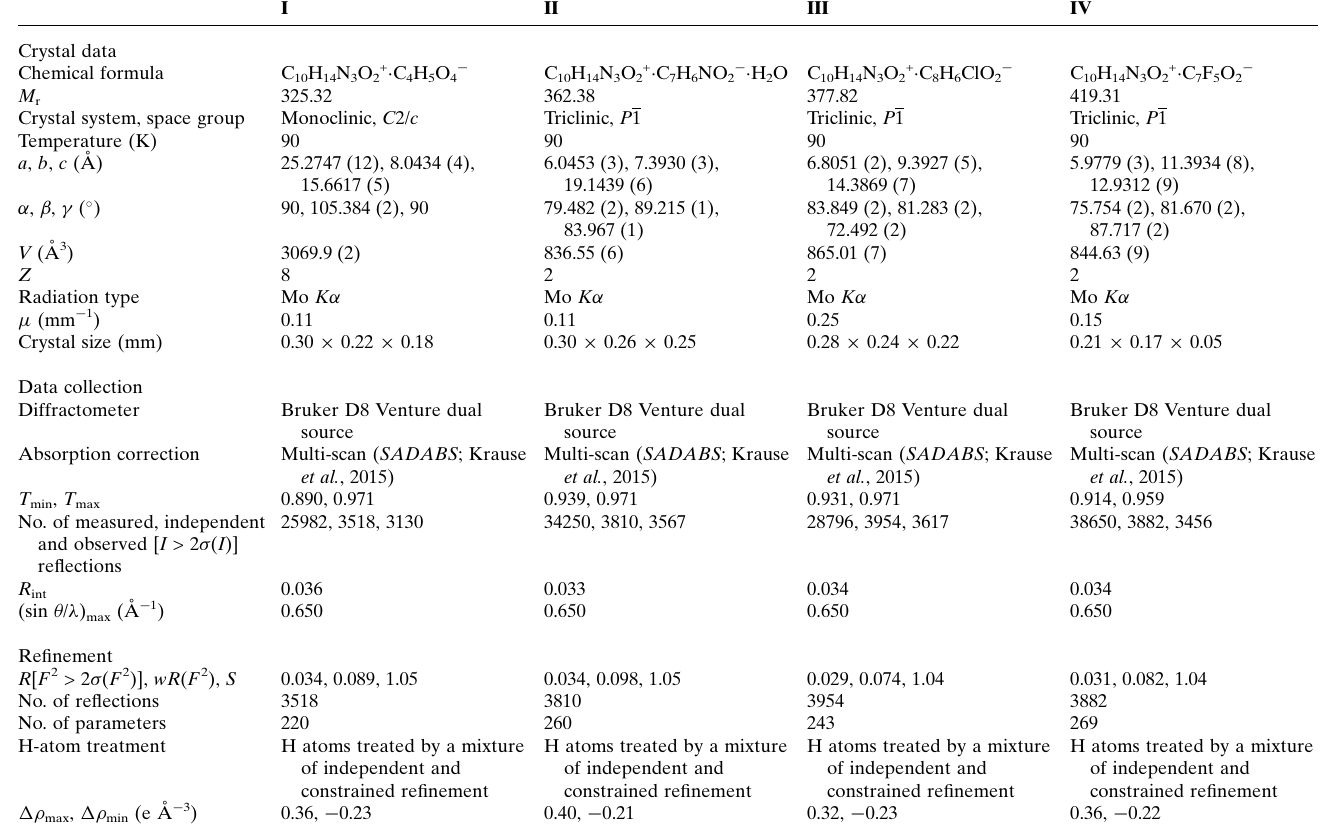
Table 5 Experimental details.